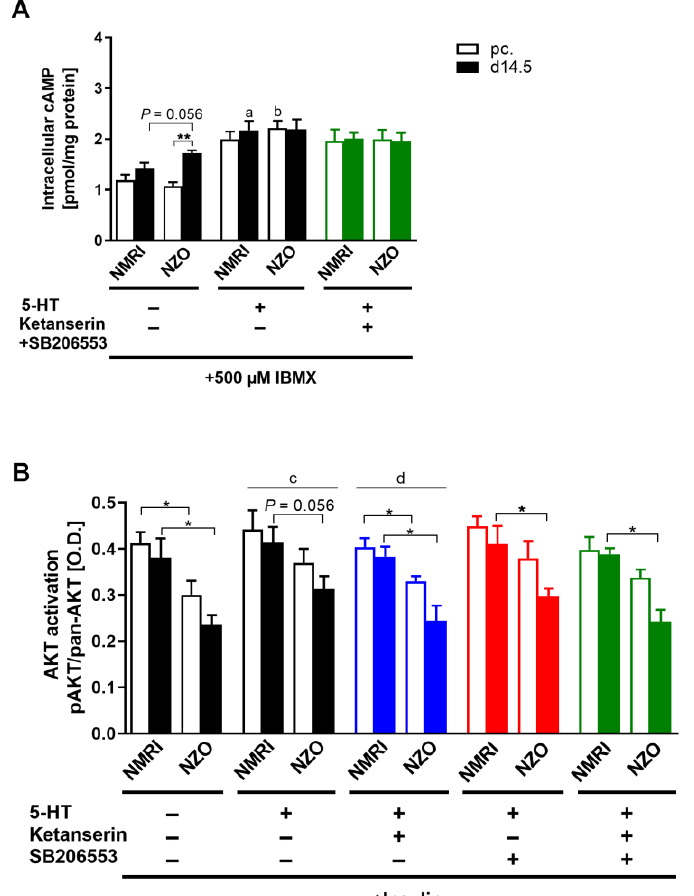
Figure 8. Impact of 5-HT on intracellular cAMP and AKT activation. ( A ) Intracellular cAMP content with 5-HT stimulation and co-incubation with Ketanserin and SB206553 in cultured primary hepatocytes of NMRI and NZO mice at time points preconceptional (open bars) and d14.5 of gestation (filled bars); IBMX, 3-Isobutyl-1-methylxanthine. ( B ) AKT-activation (pAKT/pan-AKT ratio) after initial insulin stimulation and incubation with 5-HT and co-incubation with Ketanserin (HTR2A antagonist) and SB206553 (HTR2B/C antagonist). Data are presented as means ± SEM (A n = 5, B n = 5–6 animals per group). * p < 0.01, ** p < 0.01, NMRI d14.5 vs. NMRI d14.5 +5-HT: a p < 0.05, NZO pc.